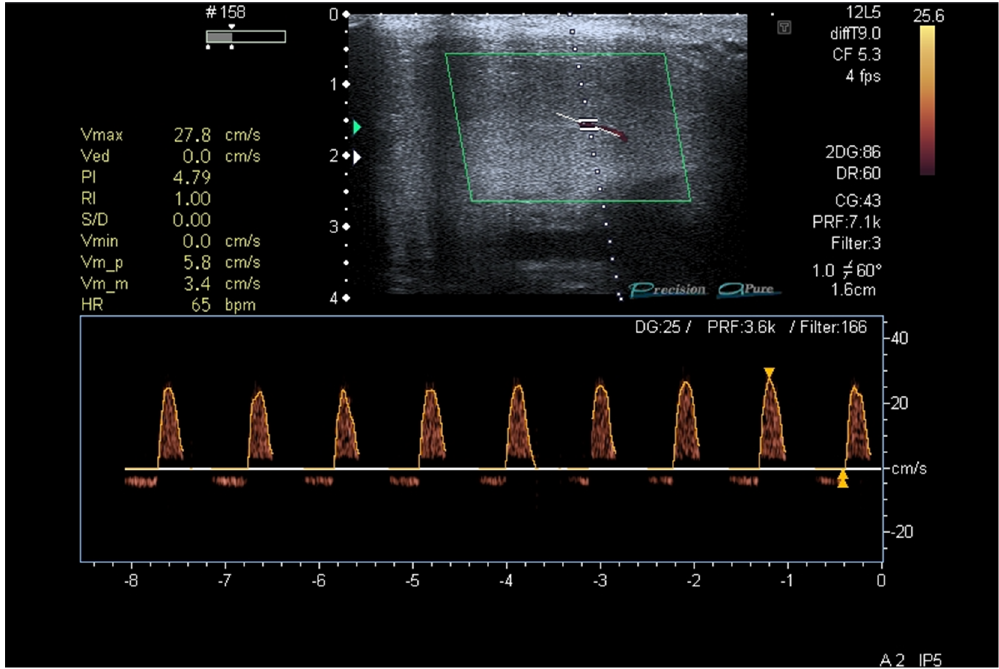
Figure 2. Penile duplex ultrasound at baseline (2 months since patient’s first